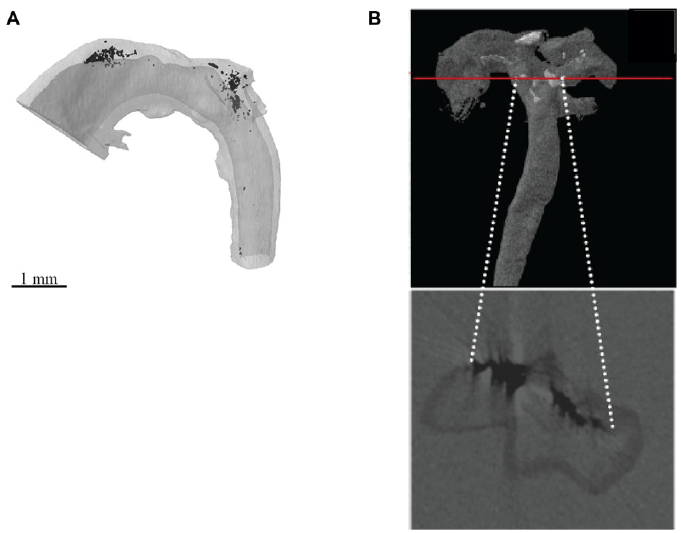
Figure 3. µ CT imaging of calcified mouse blood vessels. ( A ) A formalin-fixed, corn oil immersed aortae from the Enpp1 − / − mouse model of arterial medial calcification was scanned by µ CT using a voxel size of 10 µ m, and the images reconstructed to form a 3-D imaged volume. X-ray dense calcifications (black) localized to the upper curvature of the ascending aorta and aortic arch. ( B ) A formalin-fixed, paraffin-wax embedded aorta from the LDLR − / − mouse model of atherosclerosis and arterial intimal calcification was scanned by µ CT using a voxel size of 5.63 µ m, and the images reconstructed to form a 3-D imaged volume. X-ray dense calcifications (black) are observed in a phase virtual slice from the 3-D imaged volume (indicated by the red line). ( A ) Reproduced from Reference [73] with permission. ( B ) Reproduced from Reference [95] with permission.